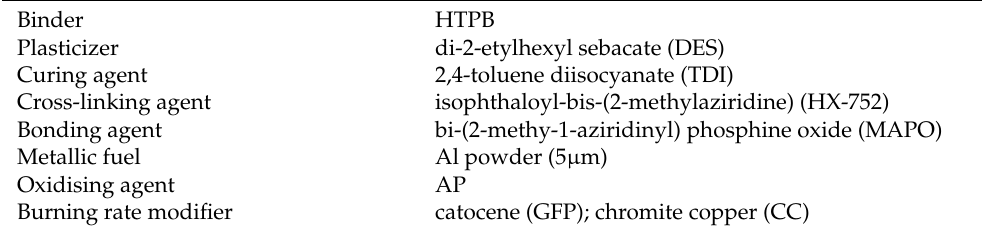
Table A3. Composition of propellant samples used in study [81].